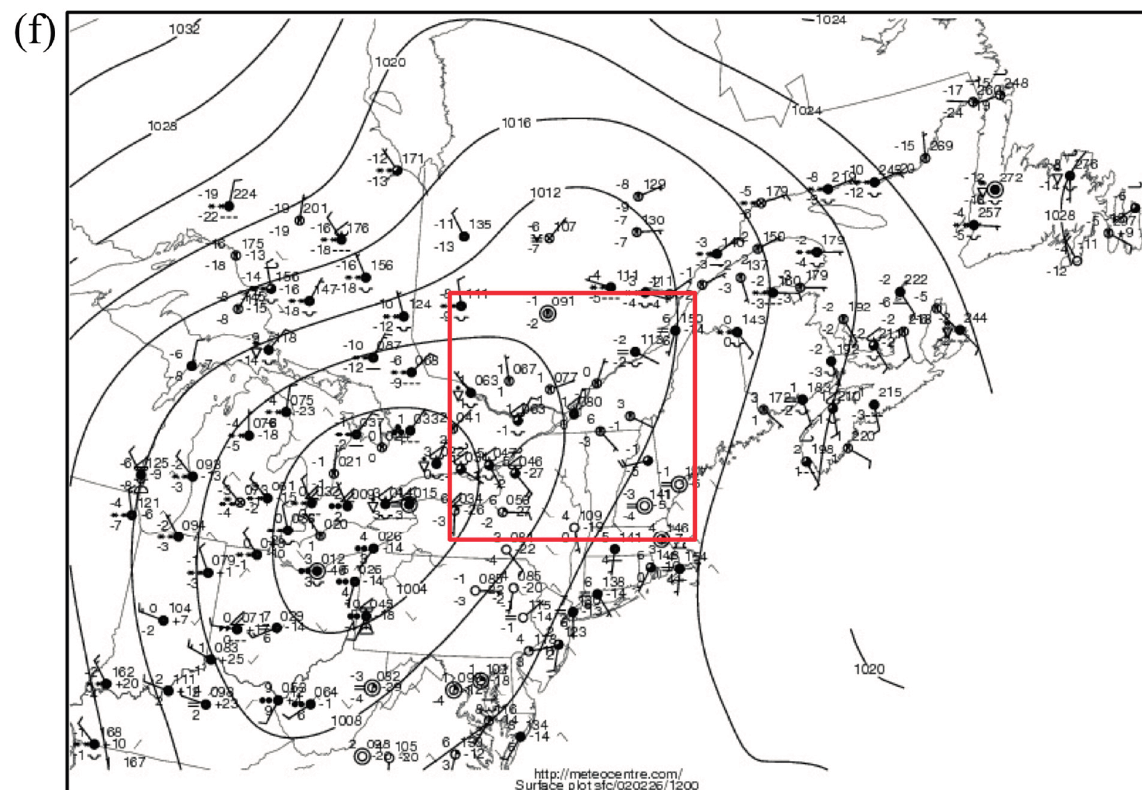
Figure 7. Typical situation for northeast winter wind channelling in the SLRV. Speed (m/s) and directions (background colors and black arrows, respectively) of the low-level wind and the mean sea level pressure (black dashed lines) for ( a ) d81, ( b ) d27, ( c ) d9, ( d ) d3 and ( e ) d1 simulations, at 1200 UTC 26 February 2002; ( f ) the corresponding analysed conditions (© [79]). The red square in (f) represents the region cover by the simulations’